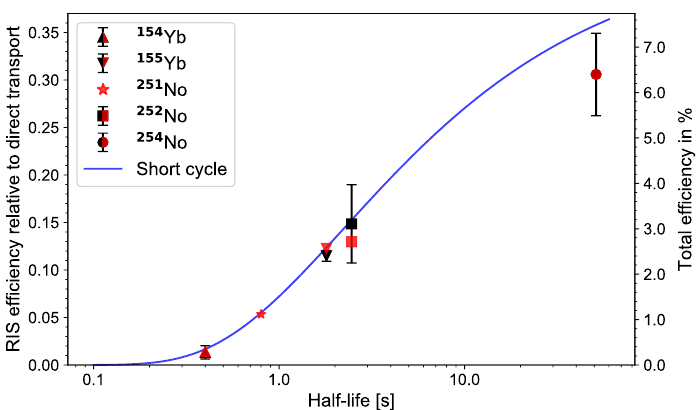
Figure 6. Comparison of efficiencies for rates of laser ions (with the laser frequency tuned on resonance) relative to direct transport rates. Experimentally determined efficiencies are shown in black. Red data points show estimated efficiencies of the RADRIS cycles in relation to the experimental RIS efficiency of 254 No. Overall efficiencies of the RADRIS setup are added with the right scale considering the known efficiency for 254 No